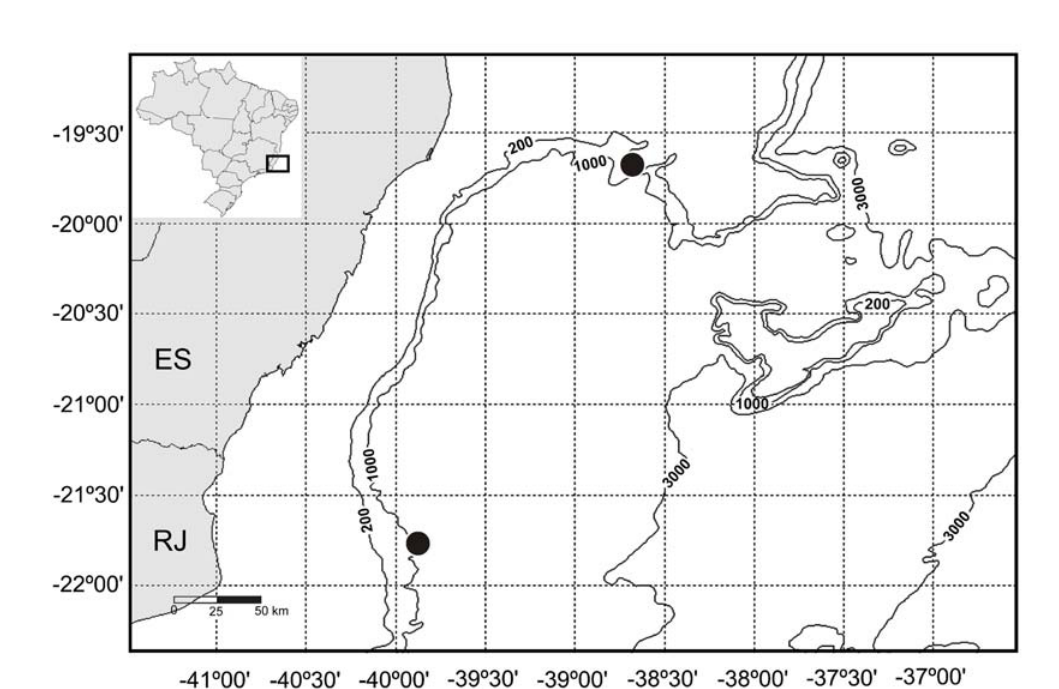
Fig. 14. Map of southeastern Brazil showing known distribution of Malacoraja obscura , new species. Abbreviations: ES, state of Espírito Santo; RJ, state of Rio de